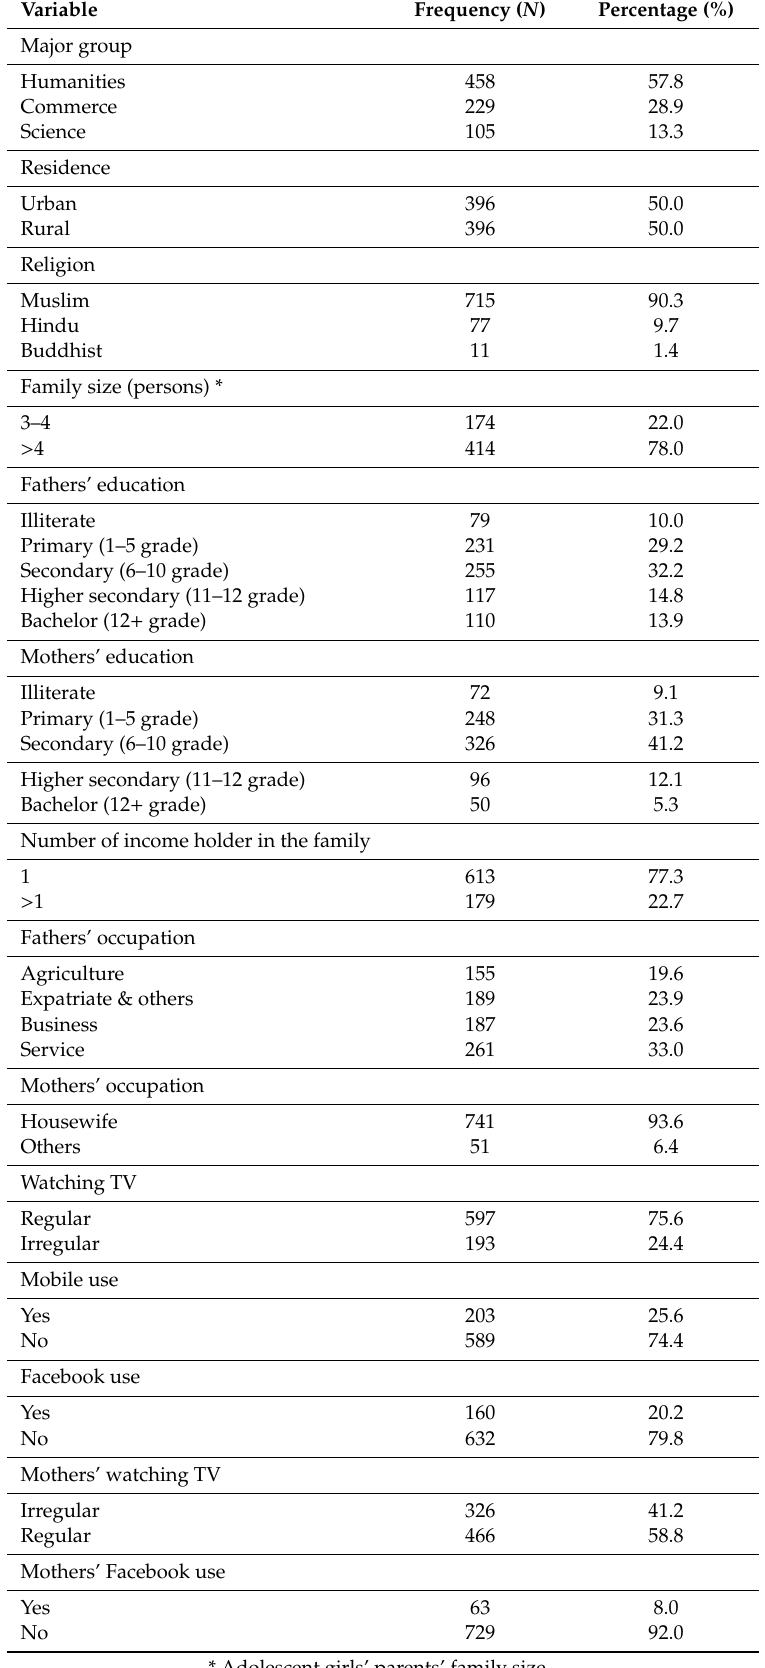
Table 1. Descriptive characteristics of older adolescent girls in the study ( N =